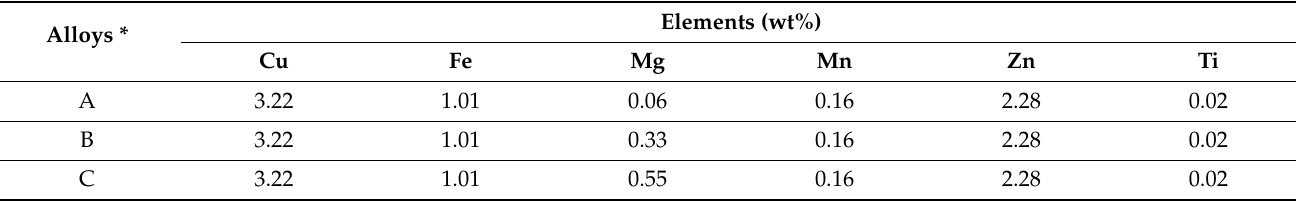
Table 3. Chemical composition of the as-cast industrial alloys.